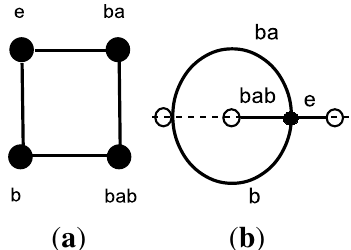
Figure 3. ( a ) The representatives of cosets for the dessin ( b ) stabilizing the square graph ( a ).